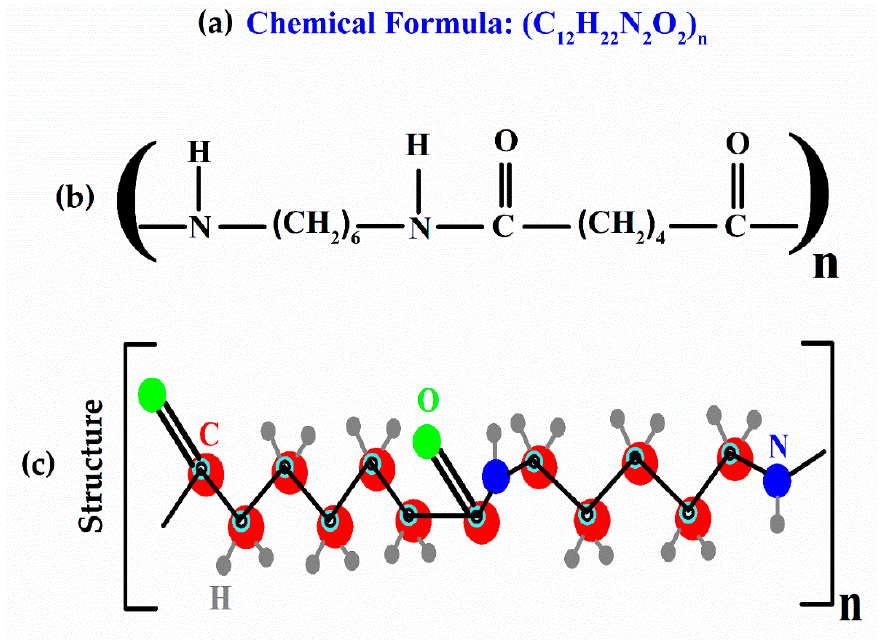
Figure 1 . Investigated nylon; ( a ) chemical formula, ( b ) 2D and ( c ) 3D molecular structure. Experimental Details